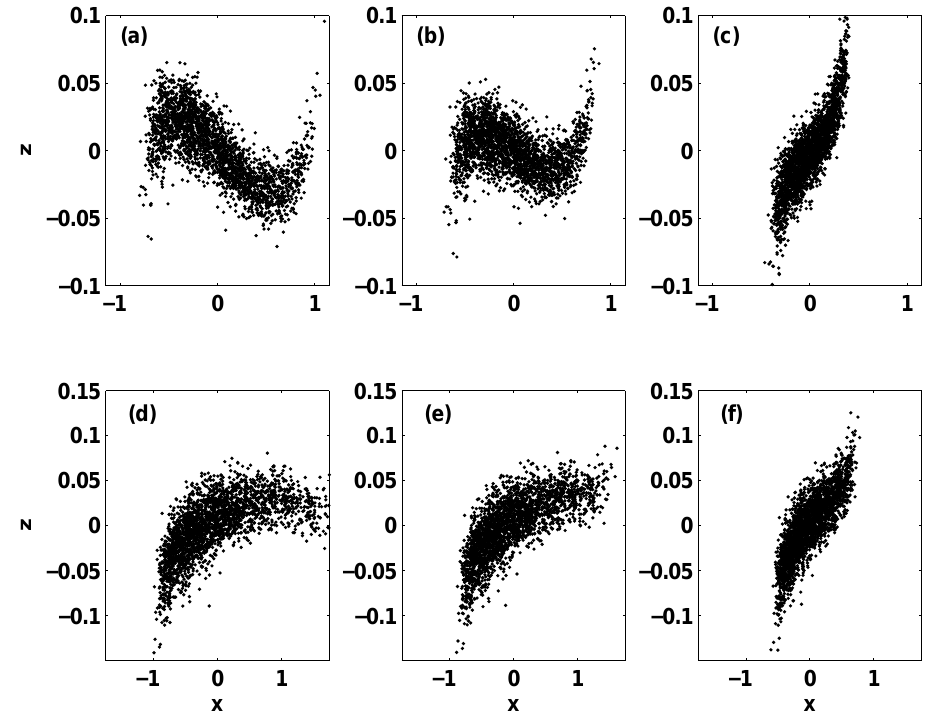
Fig. 6. The effect of wave amplitude on the particle clouds. The first column ( a and d ) corresponds to Fig. 1, the second to a 15% reduction in wave amplitude (33% reduction in wave available potential energy), and the third to a 55% reduction in wave amplitude (83% reduction in available potential energy). t = 49 . 2 (a–c) , t = 65 . 6 (d–f)